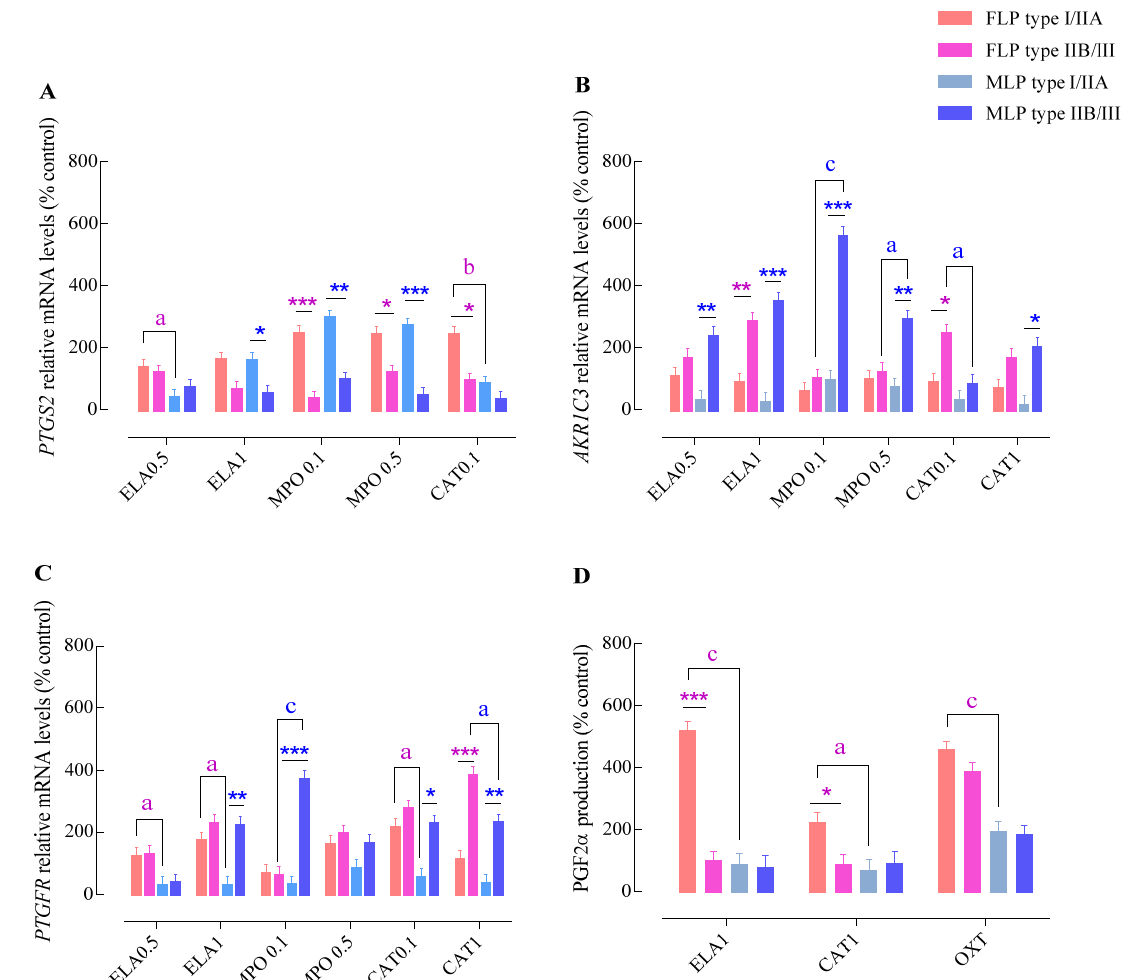
Figure 2. Effect of endometrial category (type I/IIA vs. type IIB/III) and estrous cycle phase (FLP—follicular phase FLP vs. MLP—mid-luteal phase) on PTGS2 ( A ) , AKR1C3 ( B ), or PTGFR ( C ) mRNA transcription and PGF 2 α production ( D ) in endometrial explants, incubated with different concentrations of NETs components. ELA-elastase (0.5 or 1 mg/mL); MPO—myeloperoxidase (0.1 or 0.5 mg/mL); CAT—cathepsin G (0.1 or 1 mg/mL); and OXT—oxytocin. All values are expressed as percentage of change from control (non-treated tissues). Bars represent the least significant difference (LSD) means ± SEM. Asterisks indicate significant differences between endometrial category groups (I/IIA vs. IIB/III) within each estrous cycle phase (* p < 0.05; ** p < 0.01; and *** p < 0.001); a, b, and c—letters indicate significant differences between estrous cycle phases (FLP vs. MLP) within each endometrial category group (a— p < 0.05; b— p < 0.01; and c— p < 0.001).